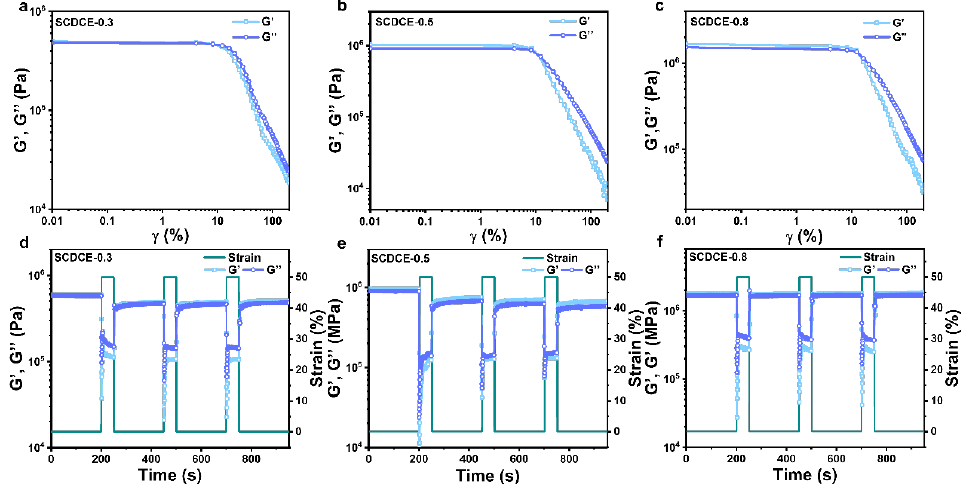
Figure 5. Self-recoverability. ( a – c ) G ′ and loss G ″ moduli vs. strain of SCDCEs at a constant fre- quency of 1.0 Hz. (( d – f ) G ′ ) and G ″ moduli vs. periodic strain (0.1% and 50%) of SCDCEs at a con- of 1.0 Hz. ( d – f ) G (cid:48) and G (cid:48)(cid:48) moduli vs. periodic strain (0.1% and 50%) of SCDCEs at a constant frequency stant frequency of 1.0 Hz. of 1.0